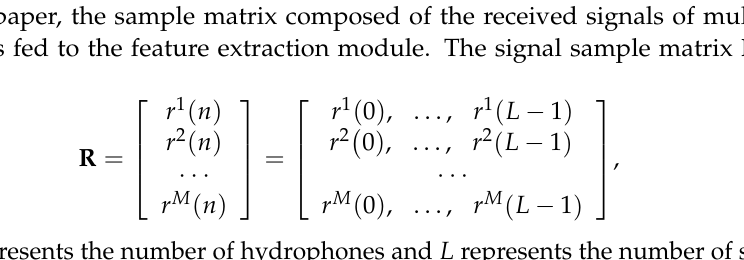
Figure 3. Structure of MHFNet.